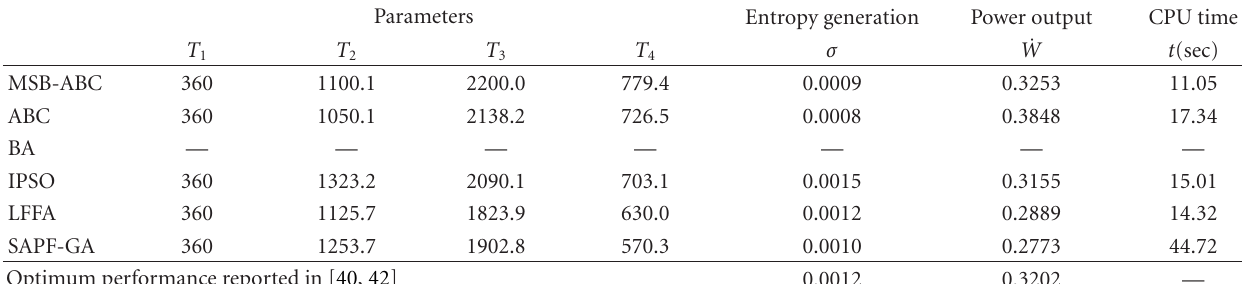
Table 3: performance of tested algorithm in γ 0 = 1 . 36 and k 1 = 0 . 00009 .